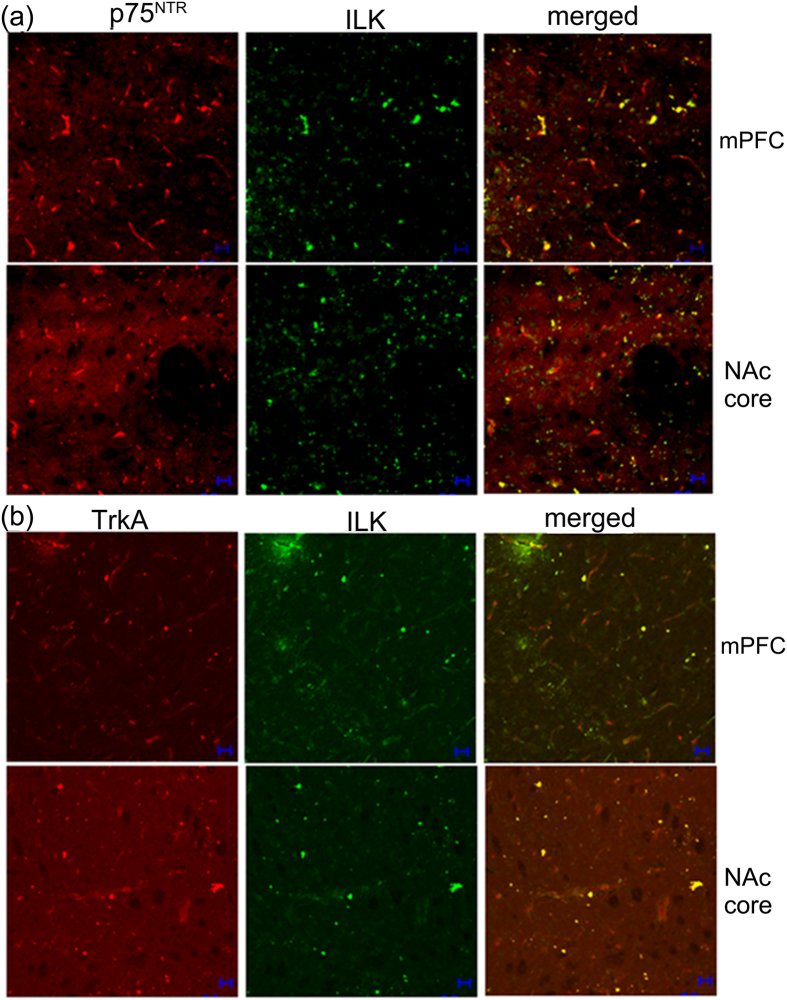
Colocalization of ILK with TrkA and p75NTR expression.Coronal sections were dually immunofluorescence stained for ILK (green) and TrkA (red) or p75NTR (red) expression. Fluorescent images were taken under Zeiss LSM 510 inverted confocal microscope. (a) ILK and p75NTR expression in the mPFC and NAc core. ILK expression is colocalized with p75NTR expression in both the mPFC and NAc core. (b) ILK and TrkA expression in the mPFC and NAc core. ILK expression is colocalized with TrkA expression in both the mPFC and NAc core. Scale bar = 20 μM.